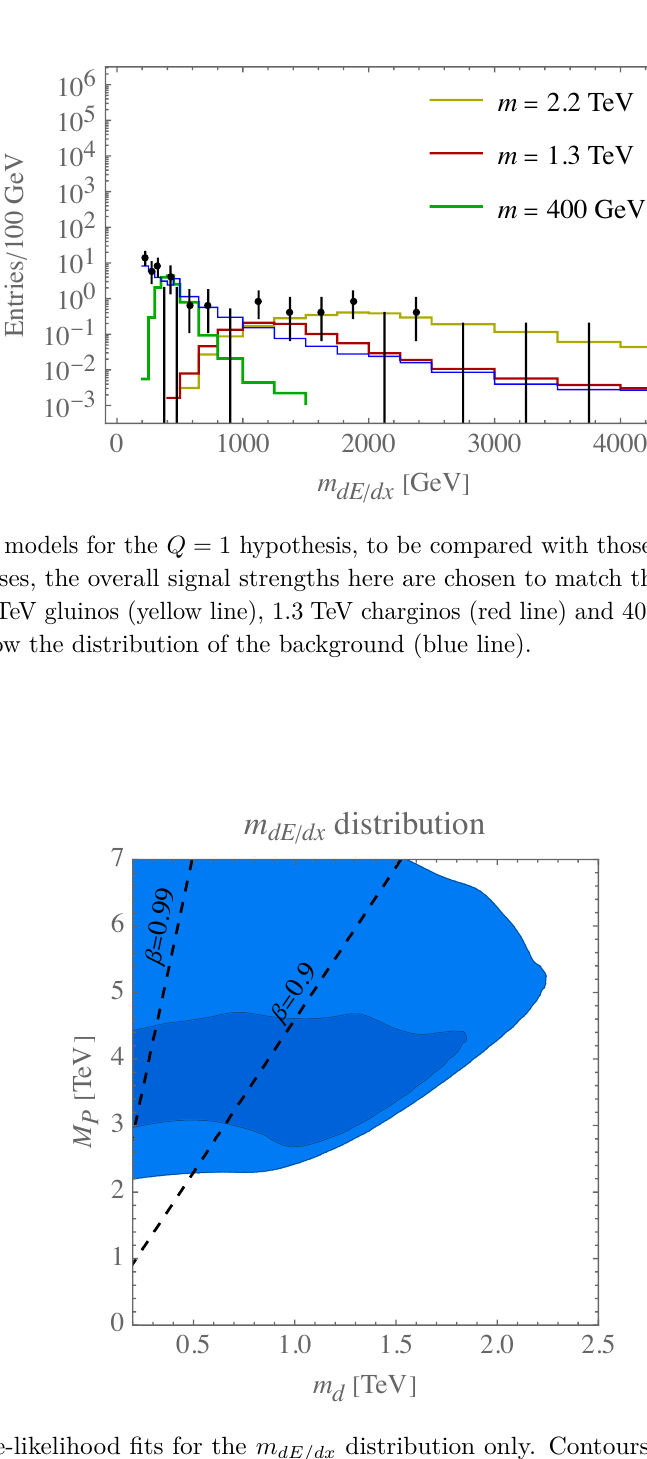
distribution only. Contours show the 1 σ and 2 σ dE/dx